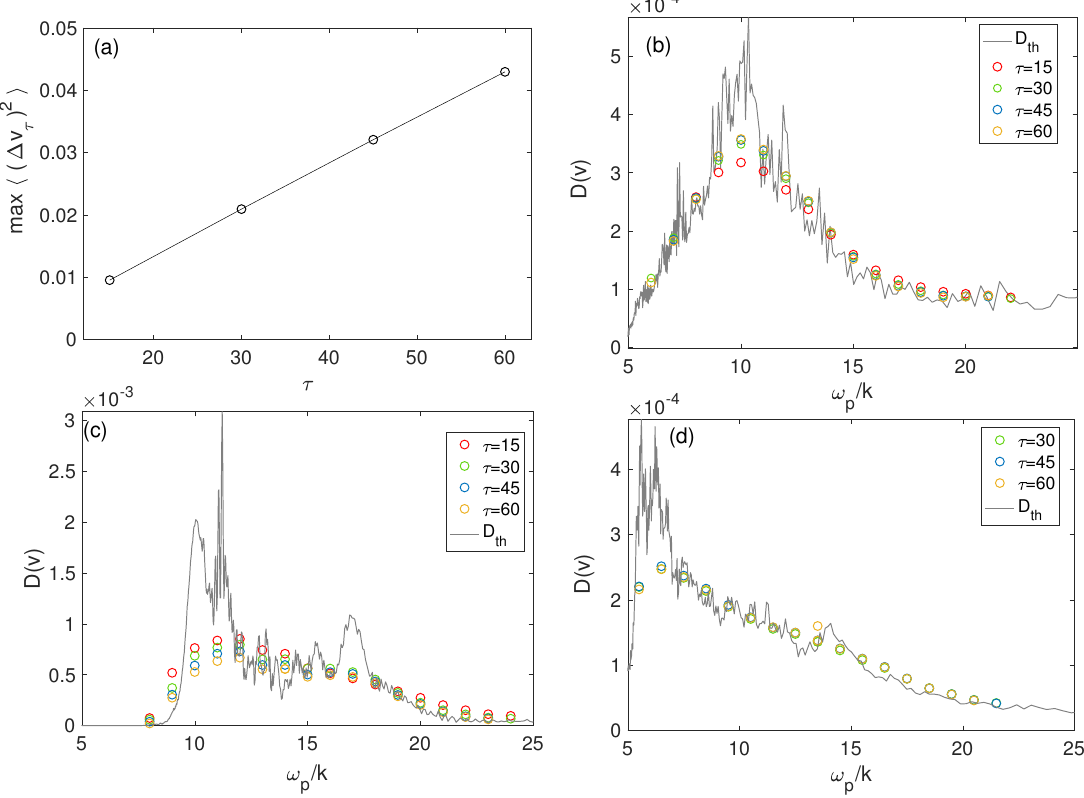
Figure 19. Diffusion in inhomogeneous plasmas. ( a , b ): Dependence of the maximum of (cid:104) ( ∆ v τ ) 2 (cid:105) on τ , and calculated diffusion coefficients D ( v ) = (cid:104) ( ∆ v τ ) 2 (cid:105) /2 τ for ∆ n = 0.01 and τ = 15, 30, 45, and 60 (red, green, blue and yellow circles, respectively), as a function of the wave phase velocity v = ω k / k (cid:39) ω p / k , superposed to the diffusion coefficient D th ( v ) derived from the quasilinear theory (grey lines). ( c , d ): Diffusion coefficients D ( v ) = (cid:104) ( ∆ v τ ) 2 (cid:105) /2 τ and D th ( v ) as a function of the wave phase velocity ω p / k ; ( c ) ∆ T = [ 35,000,43,000 ] , τ = 15,30,45,60 and ∆ n = 0.01; ( d ) ∆ T = [ 90,000,145,000 ] , τ = 30,45,60 and ∆ n = 0.04. Main parameters are: v b / v T = 14, n b / n 0 = 5 × 10 − 5 . ∆ T and τ are normalized by ω p ; the phase velocity ω p / k is normalized by v T